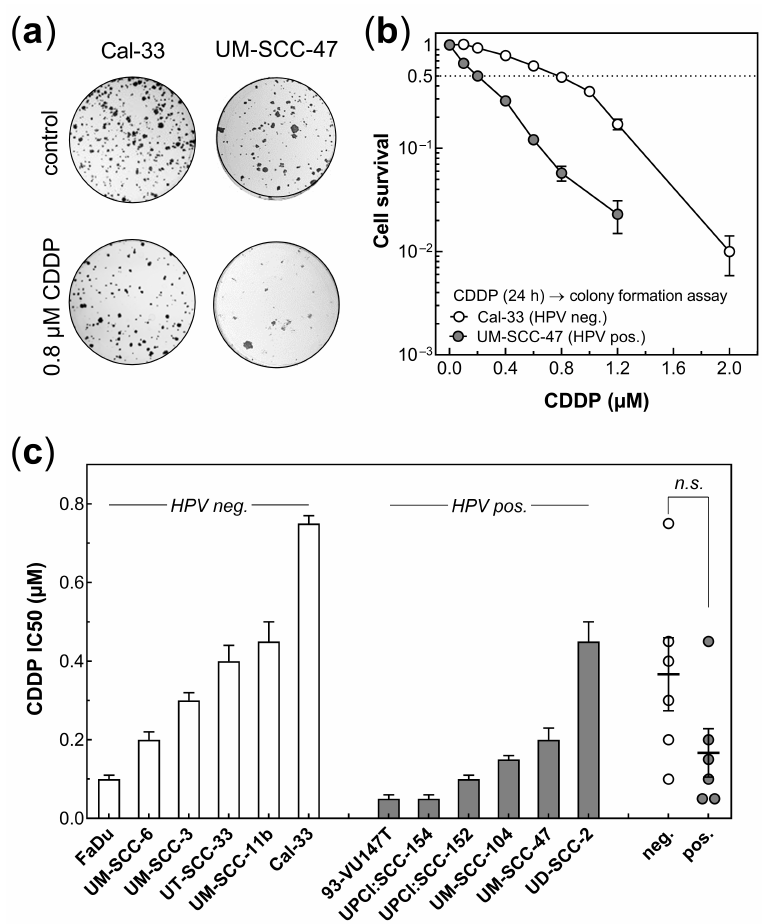
Figure 1. Cisplatin sensitivity of HPV neg. and HPV pos. HNSCC cell lines. ( a ) Cells were treated with cisplatin (CDDP) for 24 h, with concentrations of up to 2.0 µM, and survival was measured by a colony formation assay. ( b ) Cell survival for Cal-33 and UM-SCC-47 cells. ( c ) IC50 determined for cisplatin for six HPV pos. and six HPV neg. HNSCC cell lines using the respective survival curves. A